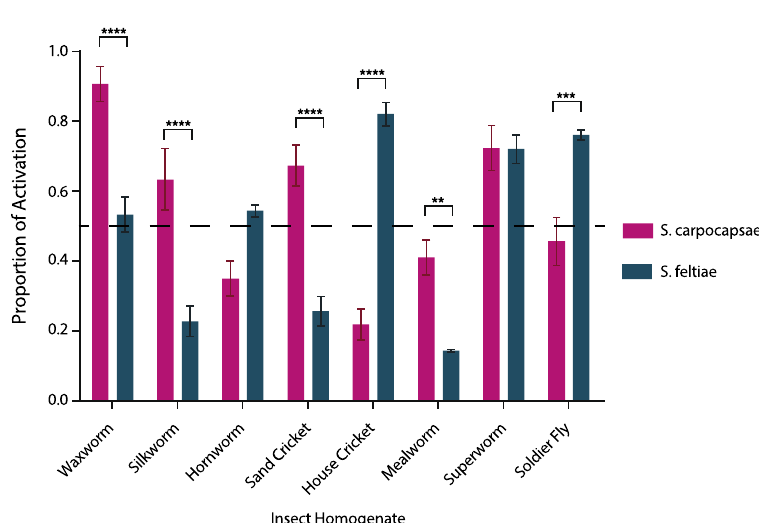
Figure 1. Activation of S. carpocapsae and S. feltiae infective juveniles (IJs) when exposed to different host homogenates. Infective juveniles were exposed to each homogenate before being quantified. Values represent the proportion of IJs that were activated after 6 hours of exposure to host homogenate and data were analyzed using the 2-way ANOVA test in GraphPad Prism software (Table A1). Comparisons between S. carpocapsae and S. feltiae for different homogenates were assessed using Sidak’s multiple comparisons test. The means from three independent experiments are shown and bars represent standard errors. ** p < 0.01, *** p < 0.001, **** p < 0.0001.